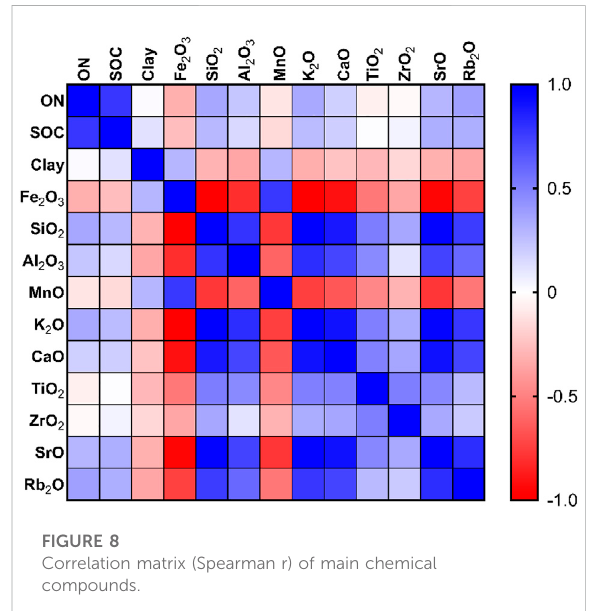
FIGURE 8 Correlation matrix (Spearman r) of main chemical